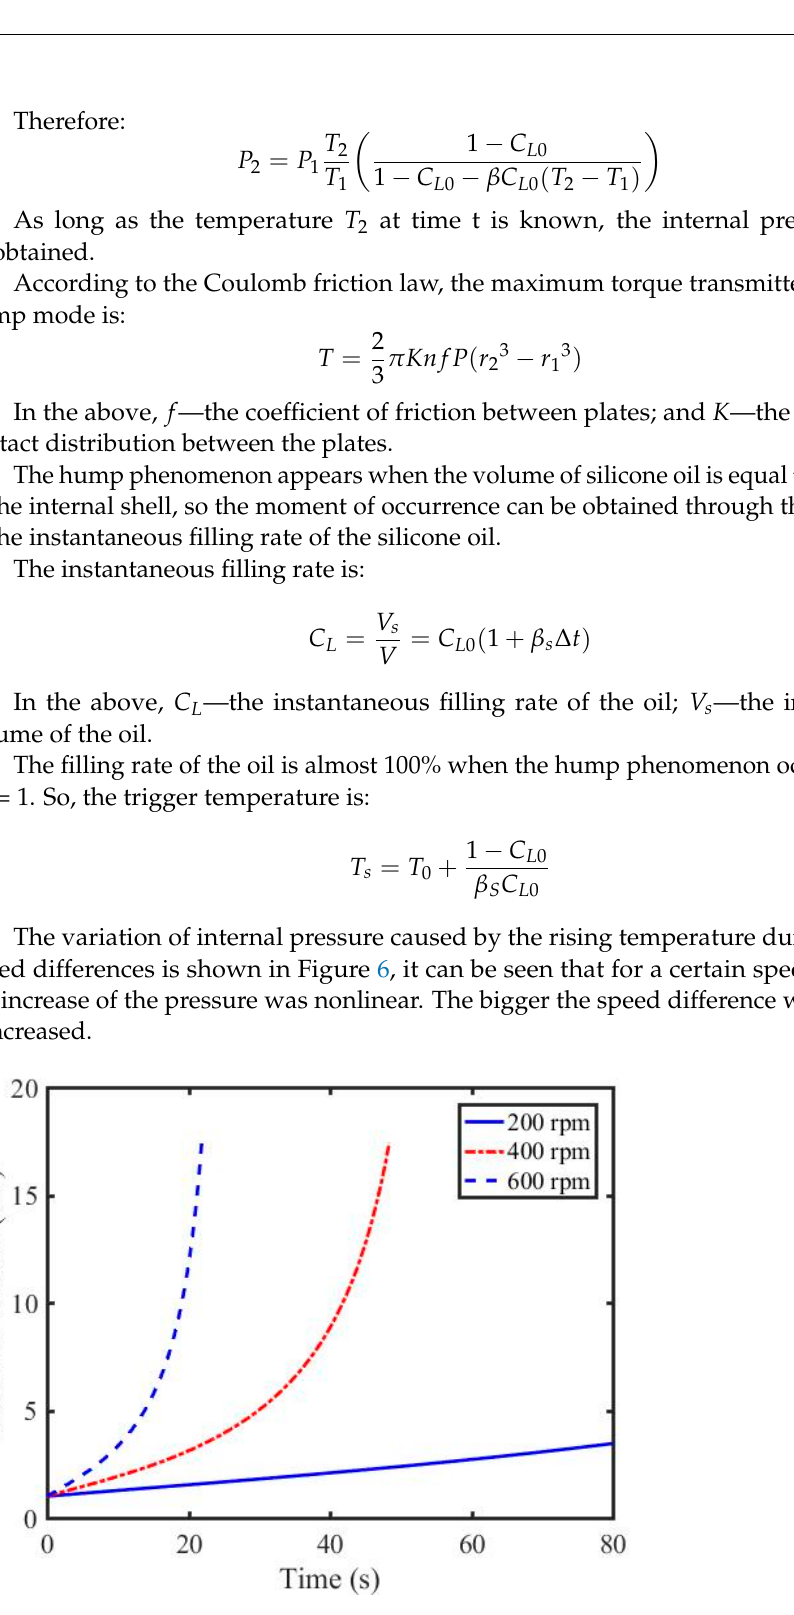
Figure 6. The variation of internal pressure at different speeds.